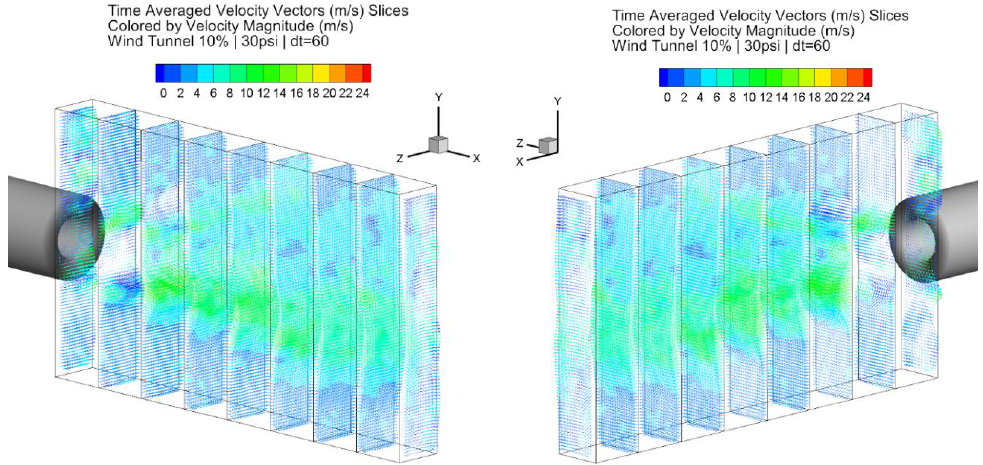
Figure 16. Time-averaged 3D velocity vector slices for the 10% freestream and 30 psi vortex pressure case from two perspective views.